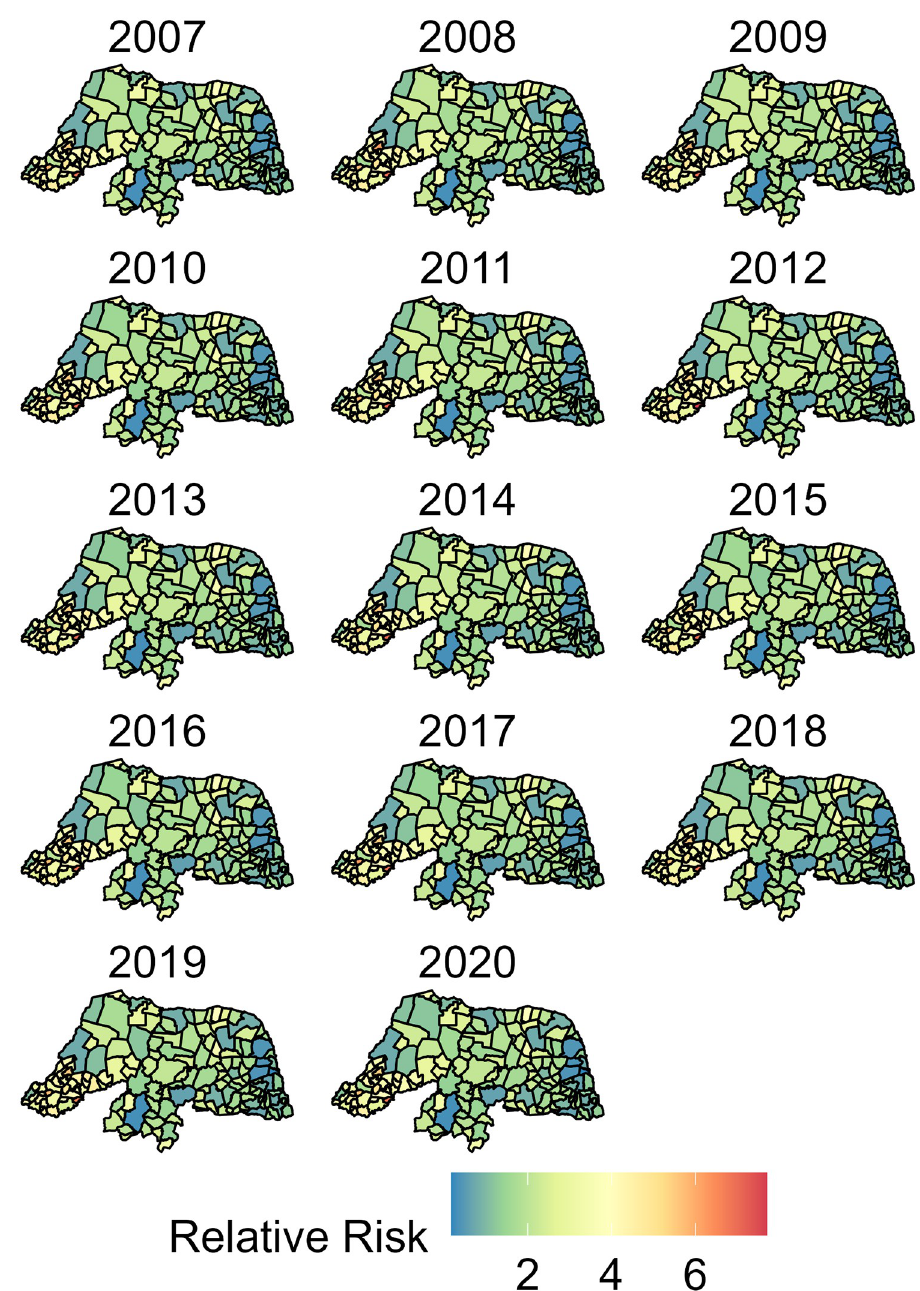
Fig 9. Spatial and Temporal posterior mode estimate of municipality-level relative risk of disease. This figure shows regions where, based on model results, it is likely that the risk of disease is higher than what we deem clinically significant. This figure was created using the geobr package in R